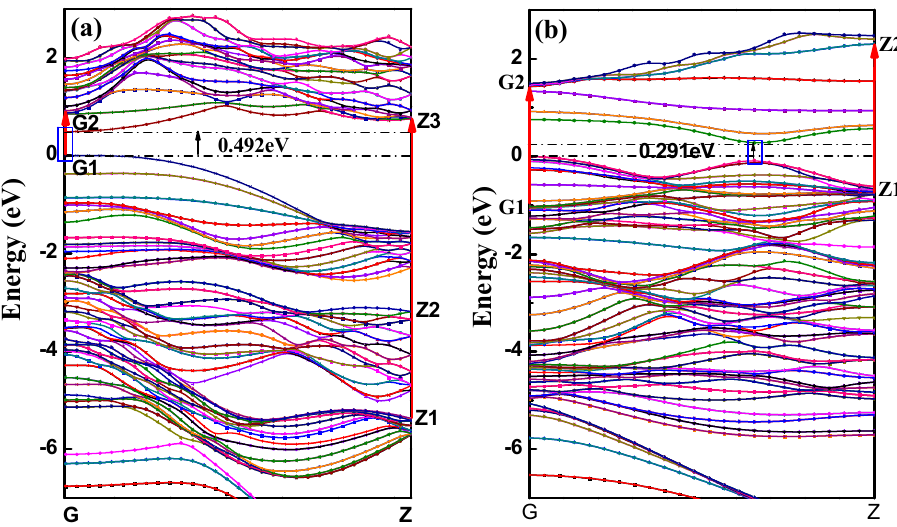
Figure 4. Band structures of BP nanotubes with a radius of 7.3 Å: ( a ) aPNT and ( b ) zPNT. The red arrows represent the inter-band transitions between the valence and conduction bands, and the black arrows point out the band-gaps of band structures of aPNT and zPNT.